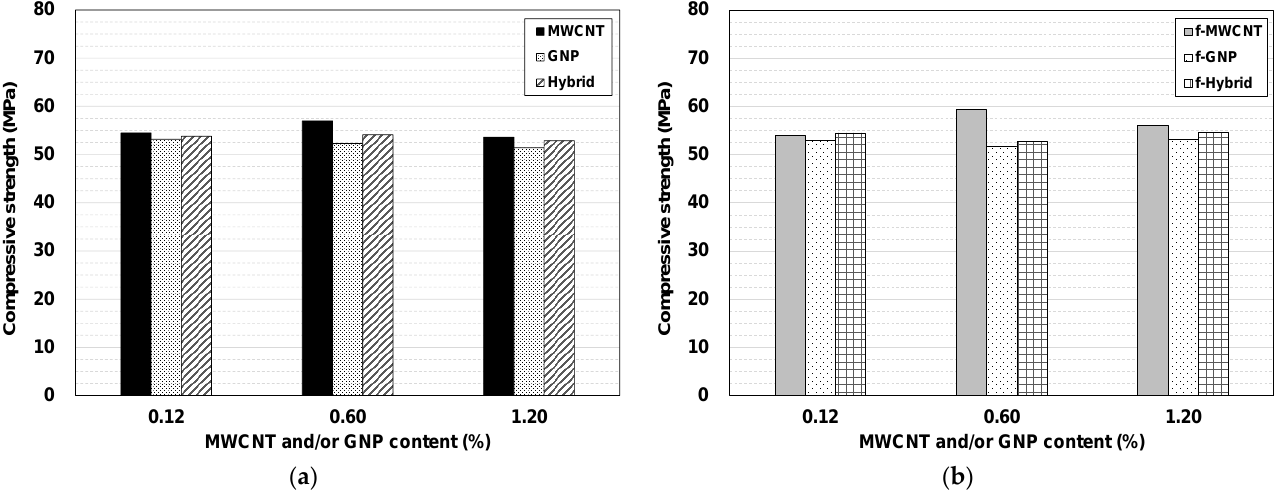
Figure 6. Effect of the hybridization of MWCNTs and GNPs on the compressive strength: ( a ) non- functionalization and ( b )